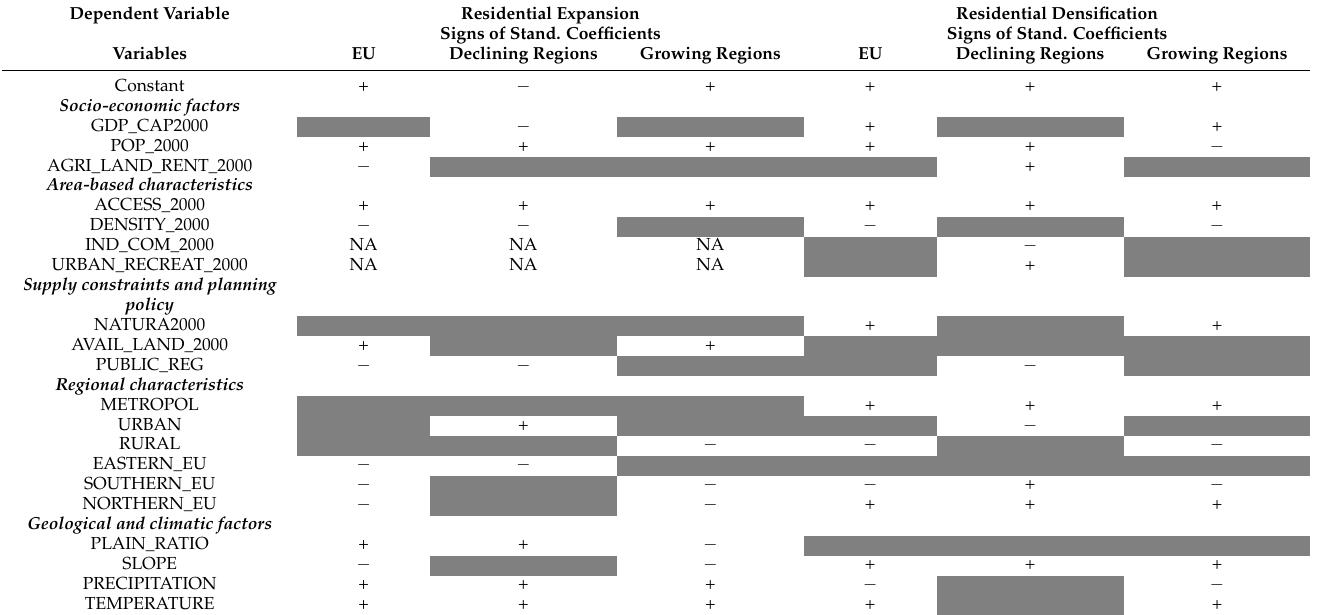
Table 5. Comparison of coefficient signs for the significant variables that explain expansion density.